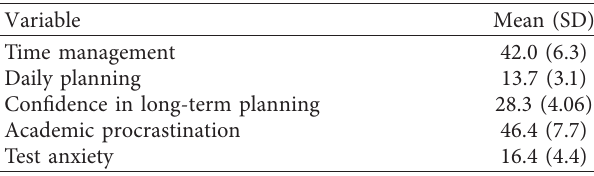
Table 2: Mean and standard deviation of time management skill (and its subscales), academic procrastination, and test anxiety.